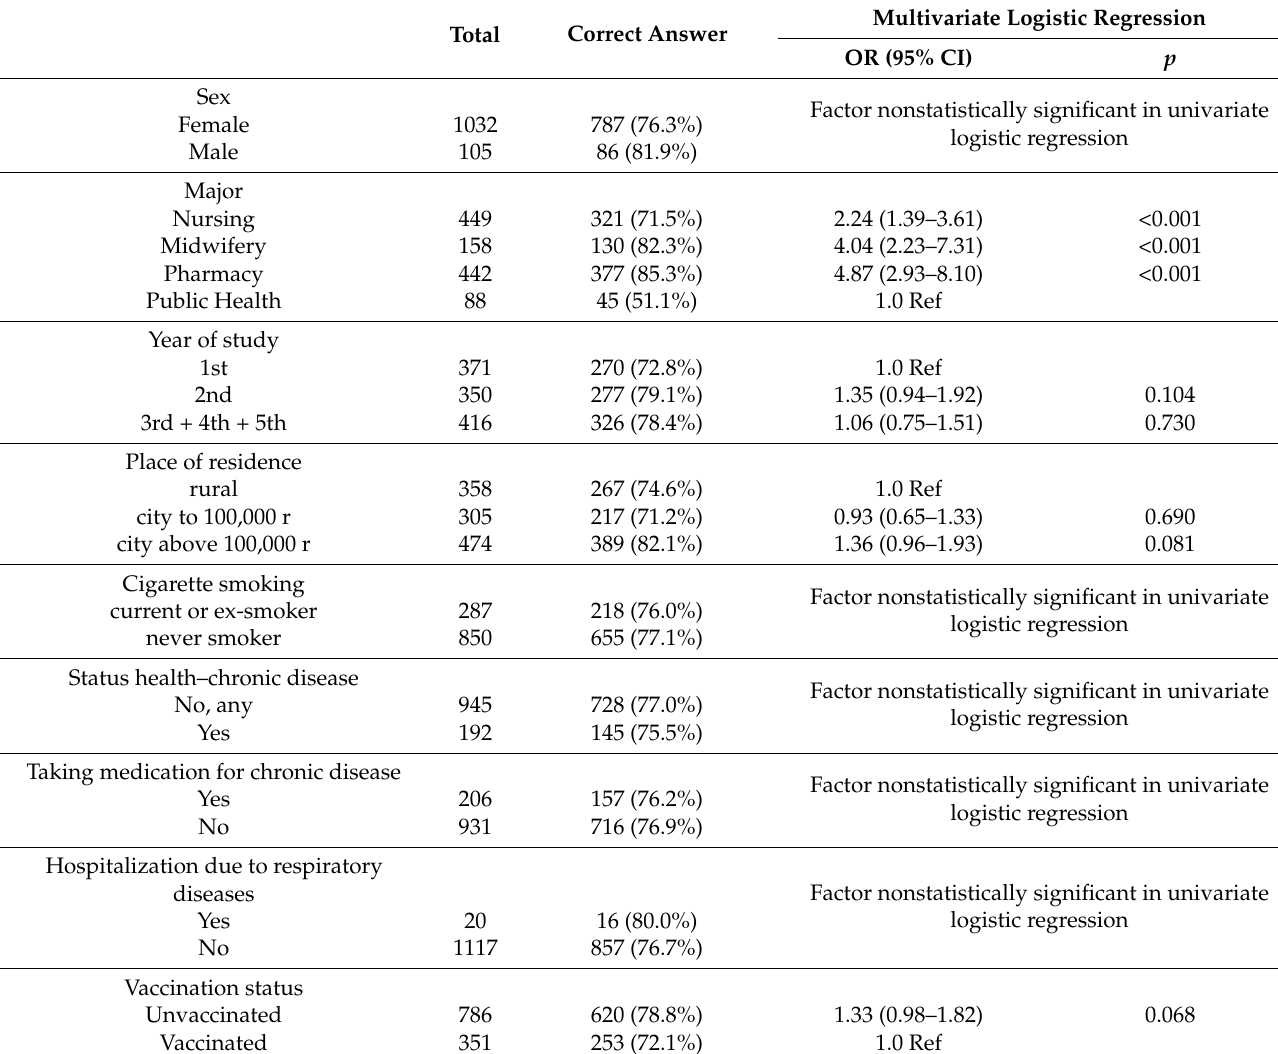
Table 7. Associations between the demographic factors (sex, major, year of study, place of residence, smoking cigarettes, status health, taking medication, and vaccination status) and the students’ knowledge about the possibility of influenza being caused by the flu